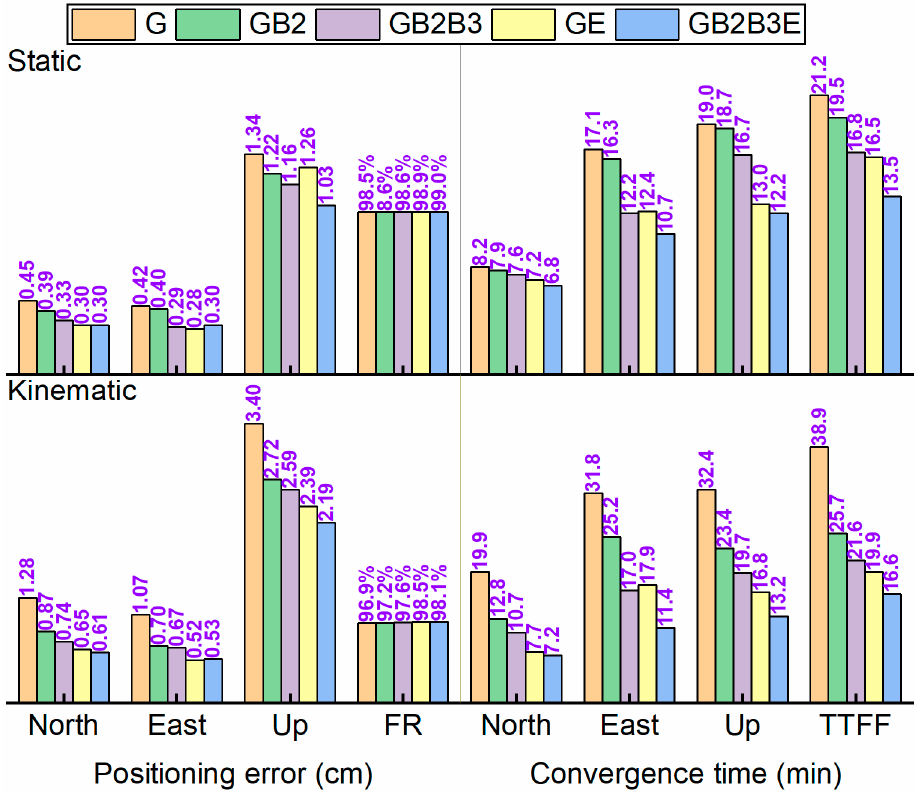
Figure 10. Average performance of multi-GNSS PPP AR in static ( top ) and kinematic ( bottom ) mode with WHU products. FR is defined as the ratio of the number of fixed epochs to the number of total epochs after TTFF and TTFF means time to first fix. The specific value is recorded at the top of the bar.